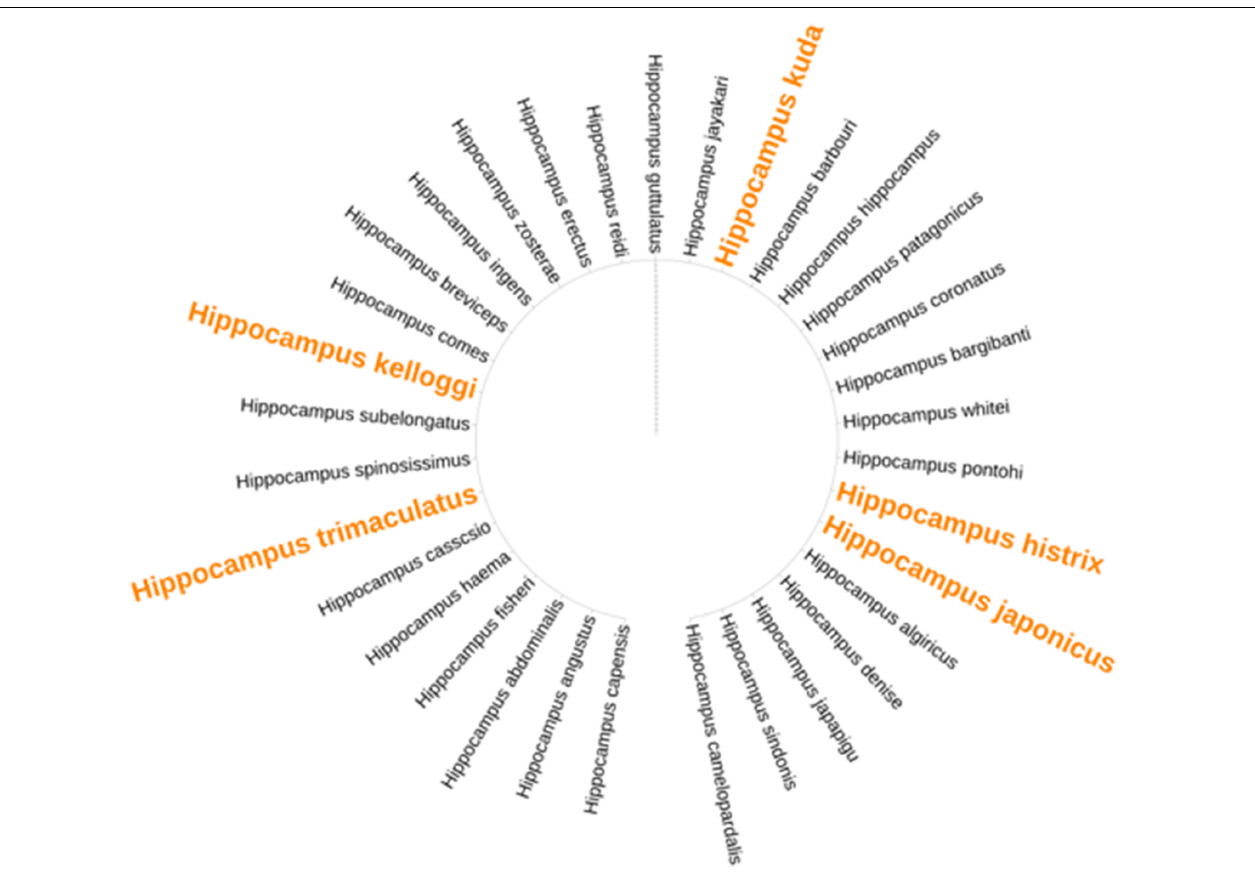
FIGURE 4 | The phylogenetic tree of 33 species of Hippocampus . Yellow fonts represent the medicinal Hippocampus